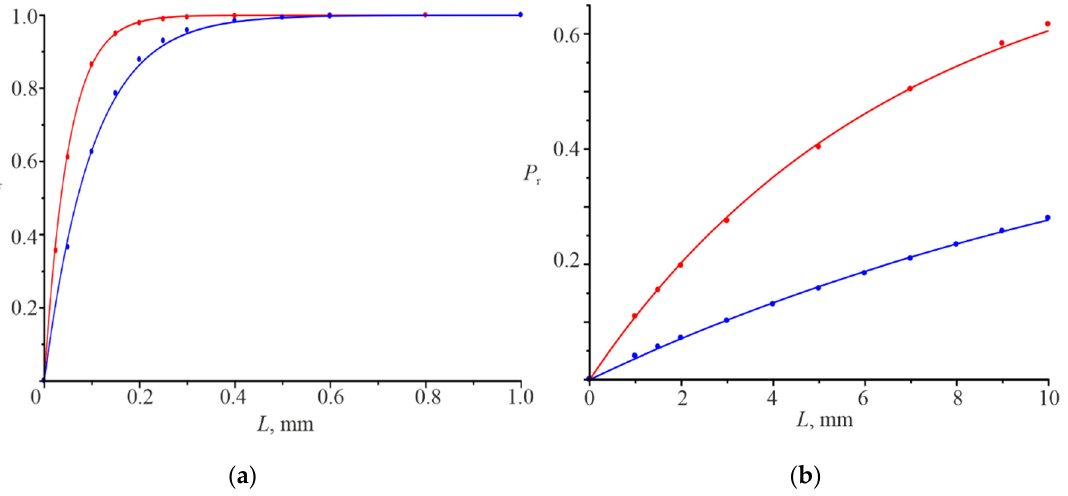
Figure 7. The distribution of the field amplitude along the 𝑥 coordinate of the incident Gaussian beam |𝑎(cid:4666)𝑥(cid:4667)| (red curve), reflected beam |𝑟 (cid:2868) (cid:4666)𝑥(cid:4667)| (blue curve), the transmitted beam |𝑡 (cid:2868) (cid:4666)𝑥(cid:4667)| (green curve) ( a ); ln|𝑟 (cid:2868) (cid:4666)𝑥(cid:4667)| (blue curve), ln|𝑡 (cid:2868) (cid:4666)𝑥(cid:4667)| (green curve) ( b ). Numerical calculations were carried out under the conditions 𝑑 = 0.78 μm,𝜆 = 1.23 μm, 𝜃 = 𝜋 18⁄ , 𝐿 = 1.5 mm .